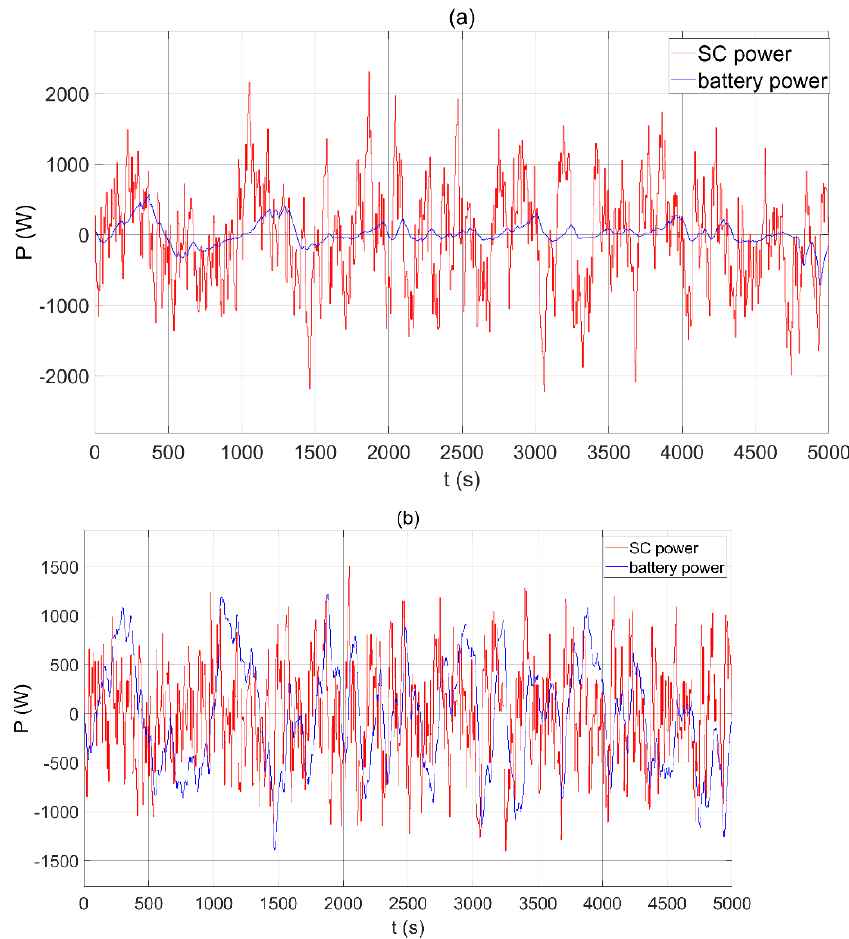
Figure 13. ( a ) Hybrid energy storage power distribution operation result of CPS-based hybrid energy storage multi-objective optimization control strategy and ( b ) traditional low-pass filter control.